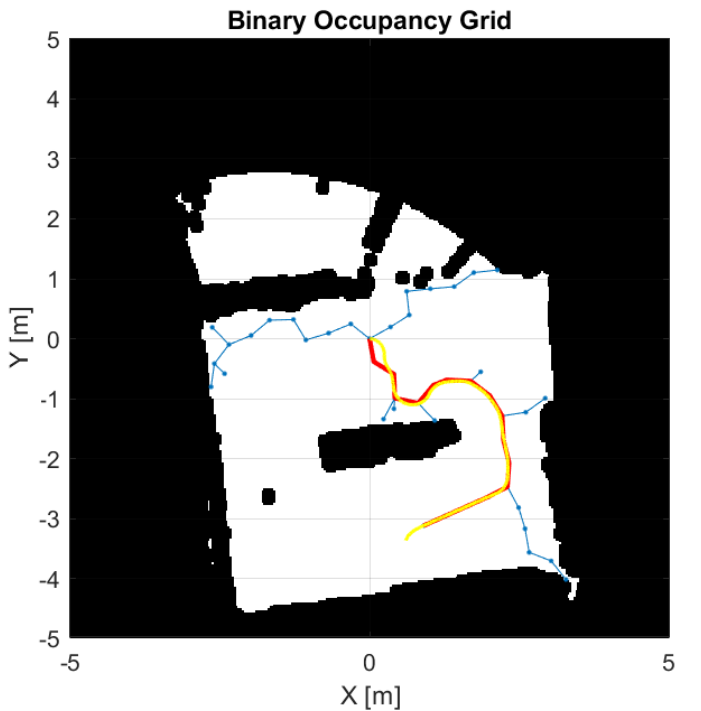
Figure 9. Desired waypoints obtained with RRT algorithm and path obtained from odometry data.